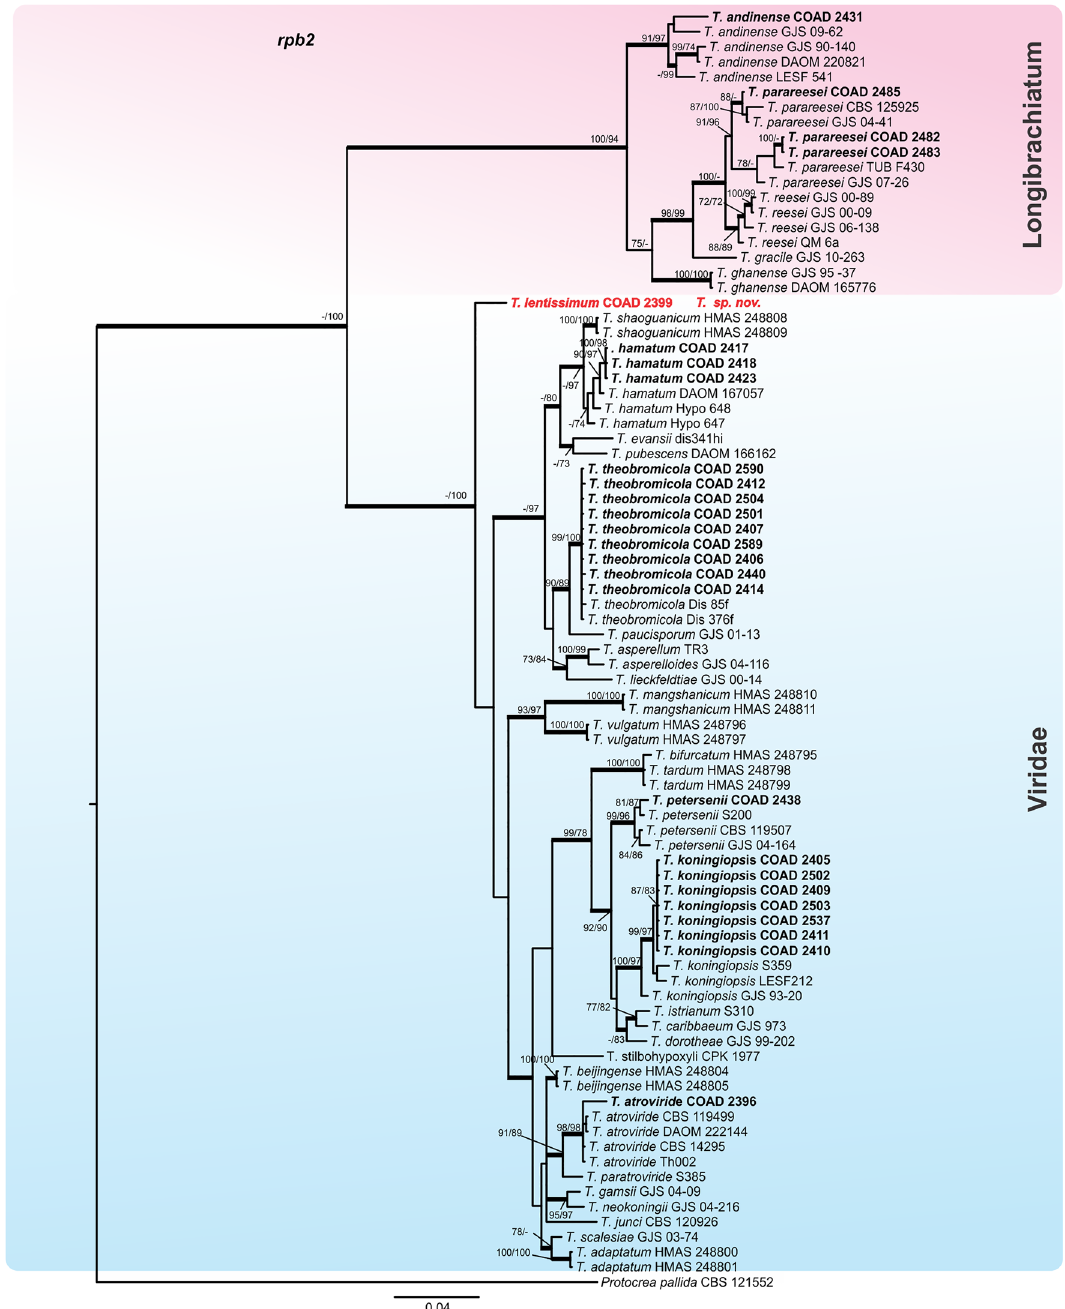
Figure 7. Bayesian phylogenetic tree of clades Longibrachiatum and Viride . The tree was based on rpb2 sequence dataset. Bootstrap values (≥ 70%) of the ML analyses, as well as posterior probability scores (≥ 0.9) from a Bayesian analysis of the same dataset, are indicated at well supported nodes together with thickened branches. The isolates belonging to known species, obtained in this study are in bold. Isolates of new species, described in thes study, are in bold red. The tree was rooted with Protocrea pallida (CBS 121552). The phylogenetic tree was edited using Inkscape 1.0 (https ://inksc